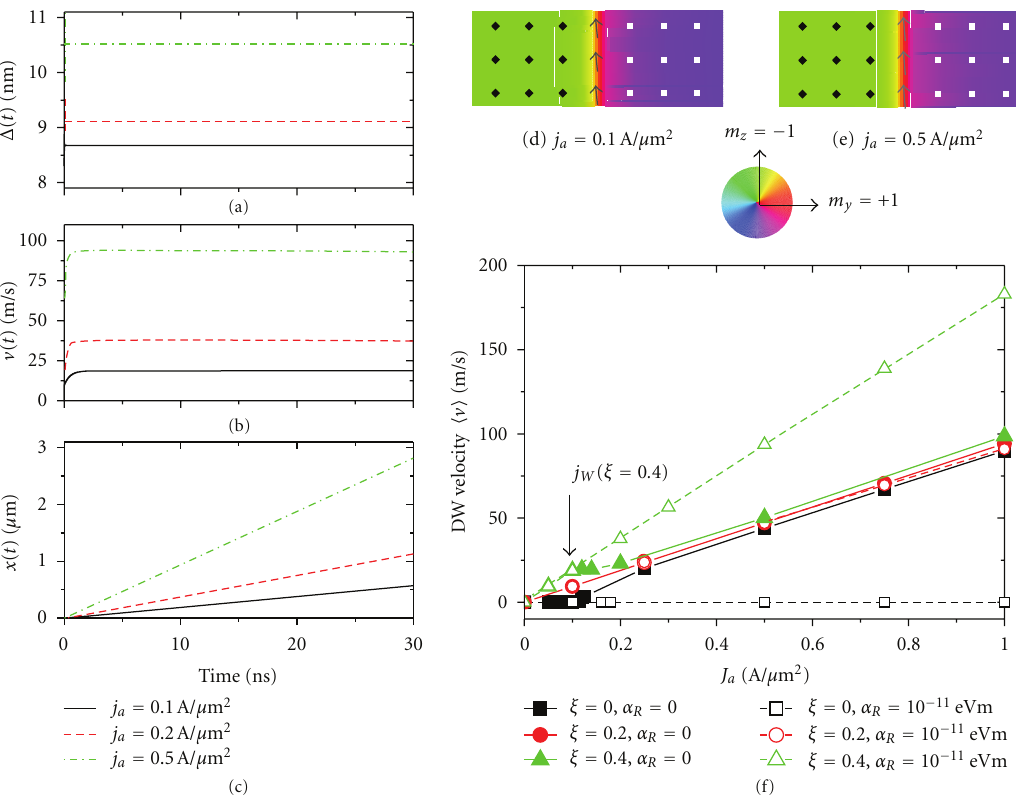
Figure 4: μM results of the current driven DW dynamics along a perfect strip with L y × L z = 120 × 3nm 2 in the presence of SOI ( α R = 10 − 11 eVm). (a), (b), and (c) depict the micromagnetically ( μM ) computed temporal evolution of the DW width Δ , the DW velocity v and the DW position x under three di ff erent density currents: j a = 0 . 1A /μ m 2 , j a = 0 . 2A /μ m 2 , and j a = 0 . 5A /μ m 2 for a nonadiabatic parameter of ξ = 0 . 4. (d)-(e) show typical micromagnetic states of the propagating DW in the presence of SOI. (f) Time-averaged DW velocity as function of j a for three di ff erent values of the nonadiabatic parameter: ξ = 0, ξ = 0 . 2, and ξ = 0 . 4. Filled and open symbols correspond to the cases with α R = 0 and α R = 10 − 11 eVm, respectivelly (Reprinted with permission From [72]. Copyright (2012), American Institute of